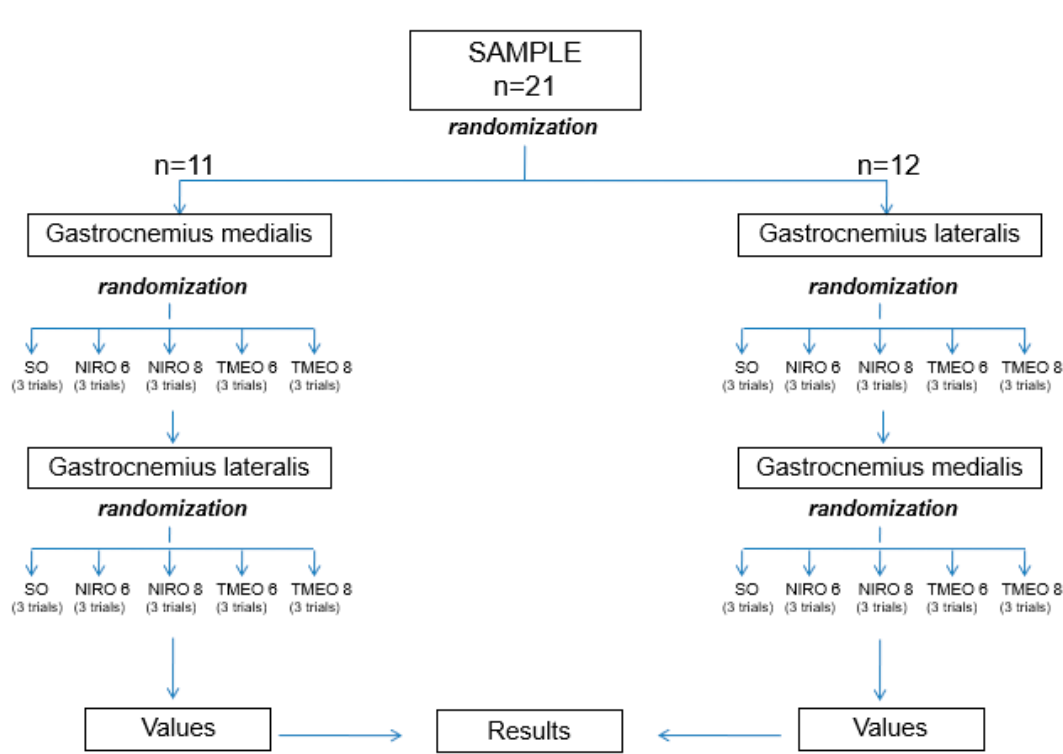
Figure 3. Randomized flow chart. Abbreviations: SO = shoe only; NIRO = novel inverted rocker orthoses; and TMEO = traditional Morton extension´s orthoses.